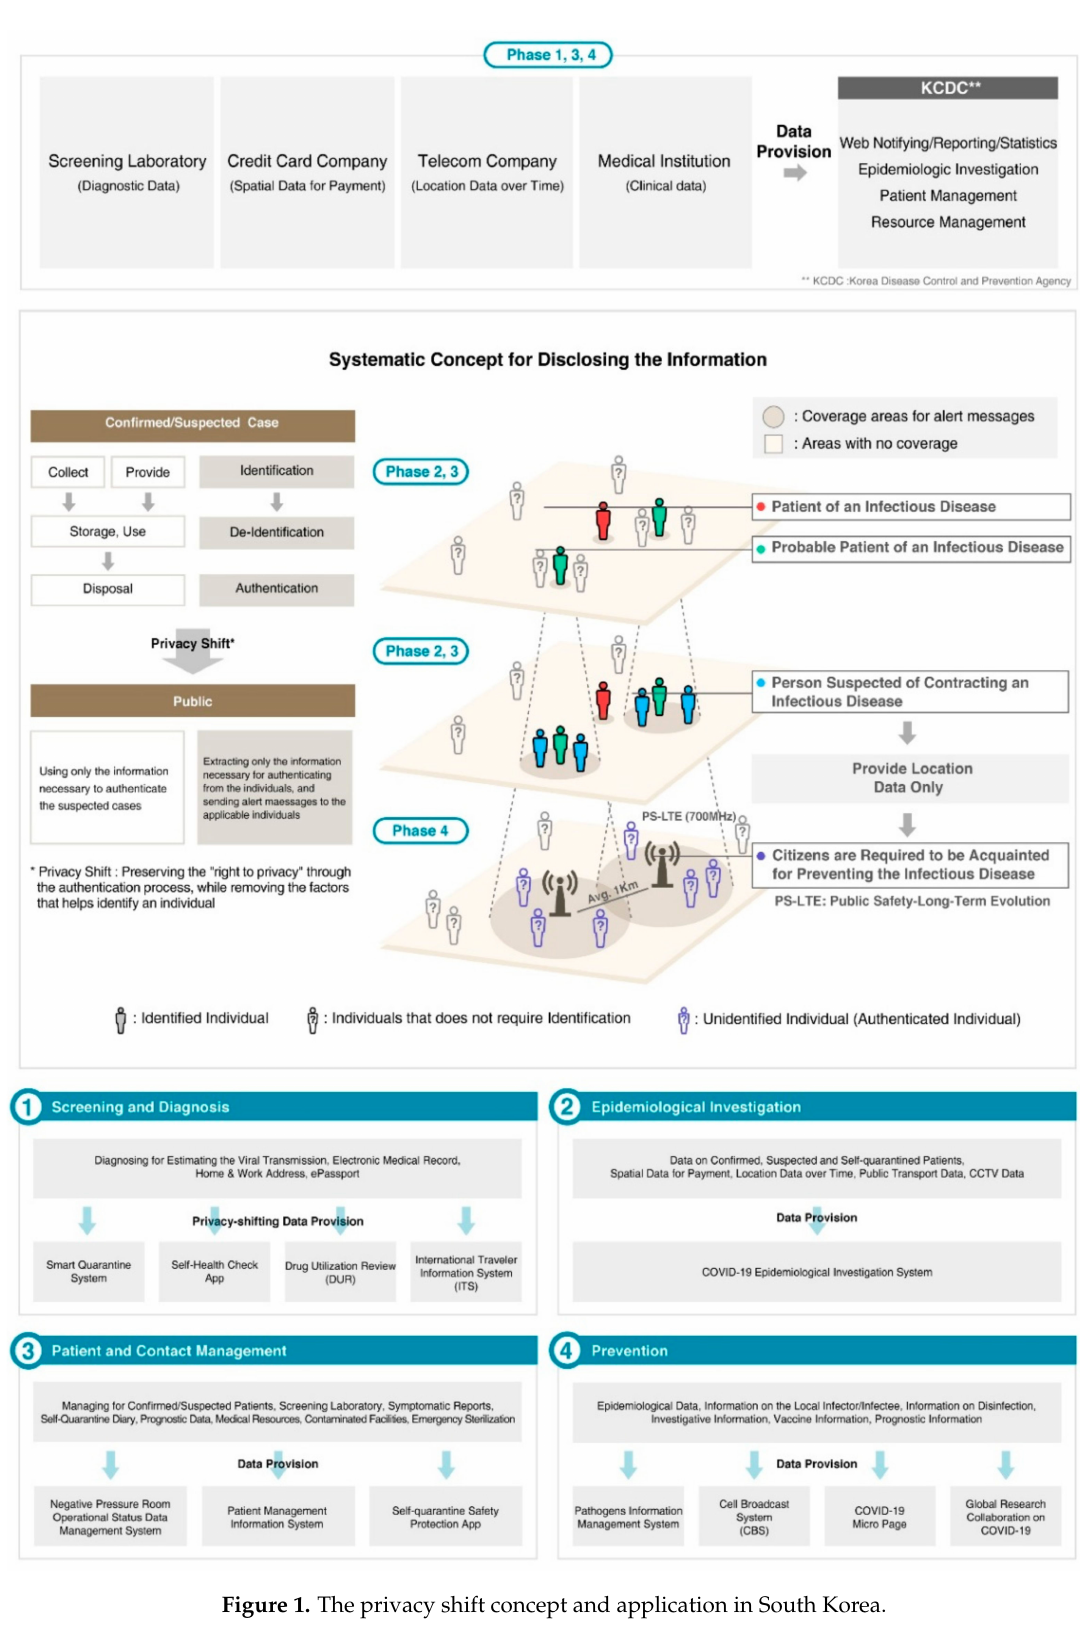
Figure 1. The privacy shift concept and application in South